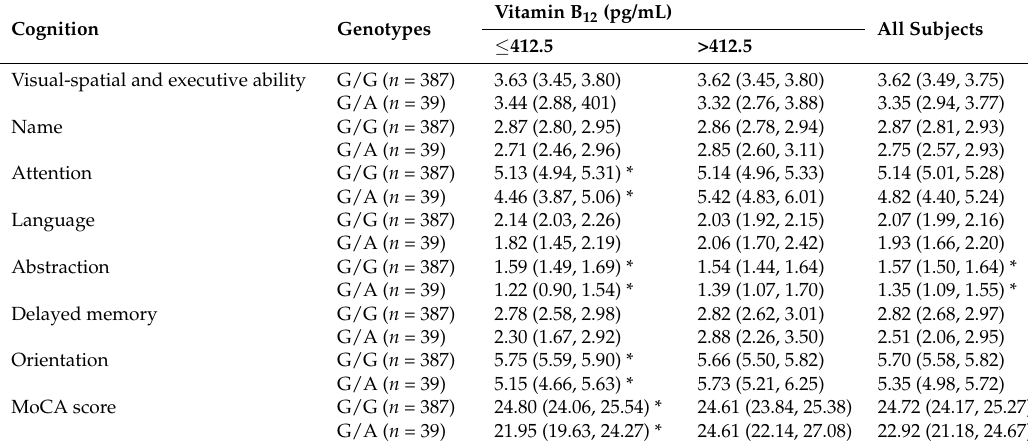
Table 6. MoCA scores by serum vitamin B 12 level and MTHFR G1793A genotypes.